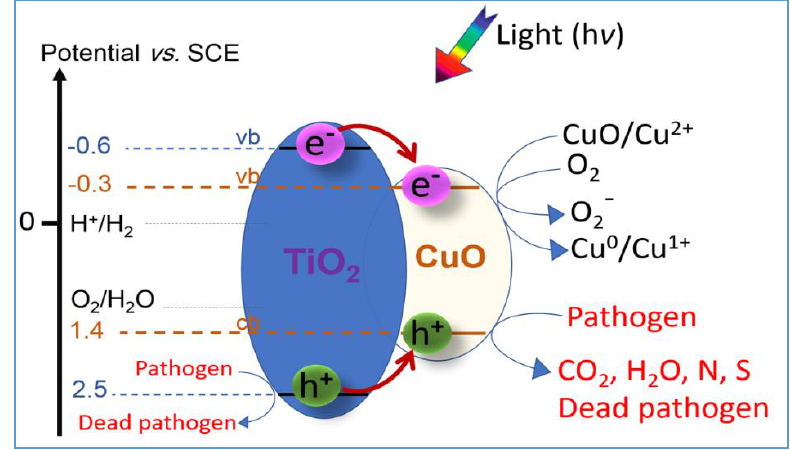
Figure 4. Interfacial charge transfer (IFCT) between CuO and TiO 2 in TiO 2 /CuO nanoparticles (NPs), leading to the inactivation of pathogens in solution under visible light.